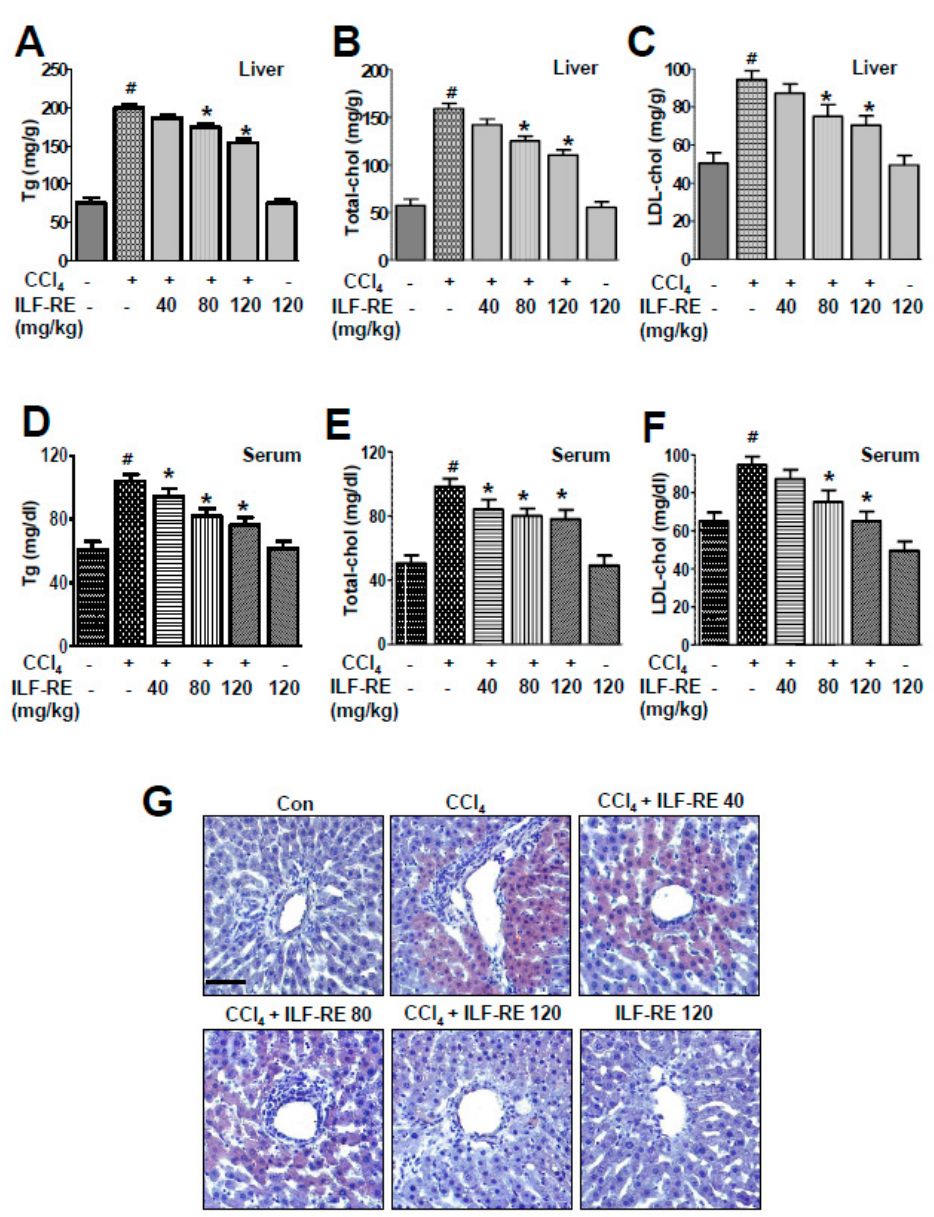
Figure 8. ILF-RE regulates hepatic lipid accumulation in CCl 4 -induced hepatotoxicity. Rats were intraperitoneally treated with CCl 4 (0.2 mL/100 g, BW) twice a day for 4 weeks. ILF-RE (40, 80, or 120 mg/kg) was co-administered with CCl 4 or 120 mg/kg ILF-RE on its own for 4 weeks, followed by harvesting of the liver and serum. Liver triglycerides ( A ), liver total-cholesterol ( B ), liver LDL-cholesterol ( C ), serum triglyceride ( D ), serum total-cholesterol ( E ), and serum LDL-cholesterol ( F ) were examined. Representative images of the liver sections from each group stained with Oil Red O for lipid content ( G ). Scale bars = 50 µ M. The experiments were performed in triplicate using tissues from at least three rats in each group. # p < 0.05 vs. Con group; * p < 0.05 vs. CCl 4 group ( n = 10 rats per group). BW, body weight; Con, control; CCl 4 , carbon tetrachloride; ILF-RE, the combination R. verniciflua with E. ulmoides.